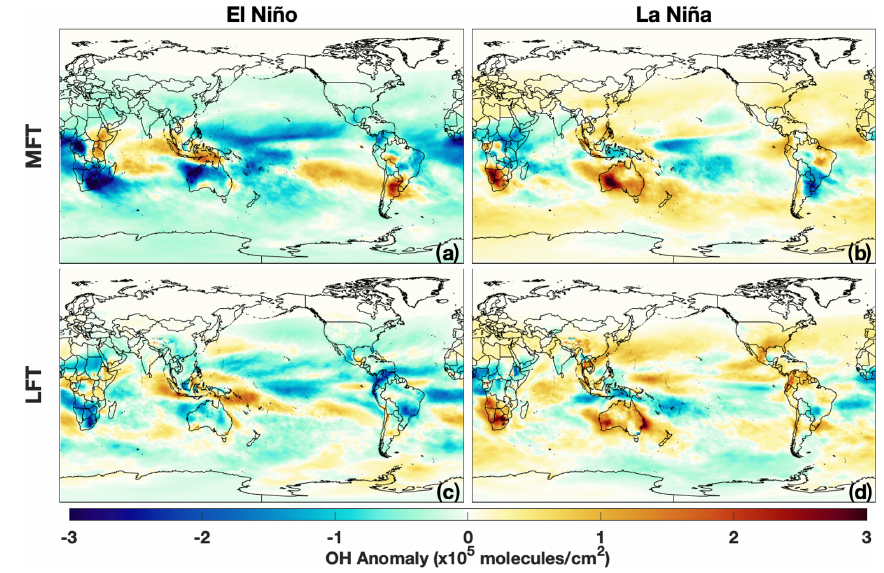
Figure 18. Same as panels (a) and (b) of Fig. 7 except for the MFT and